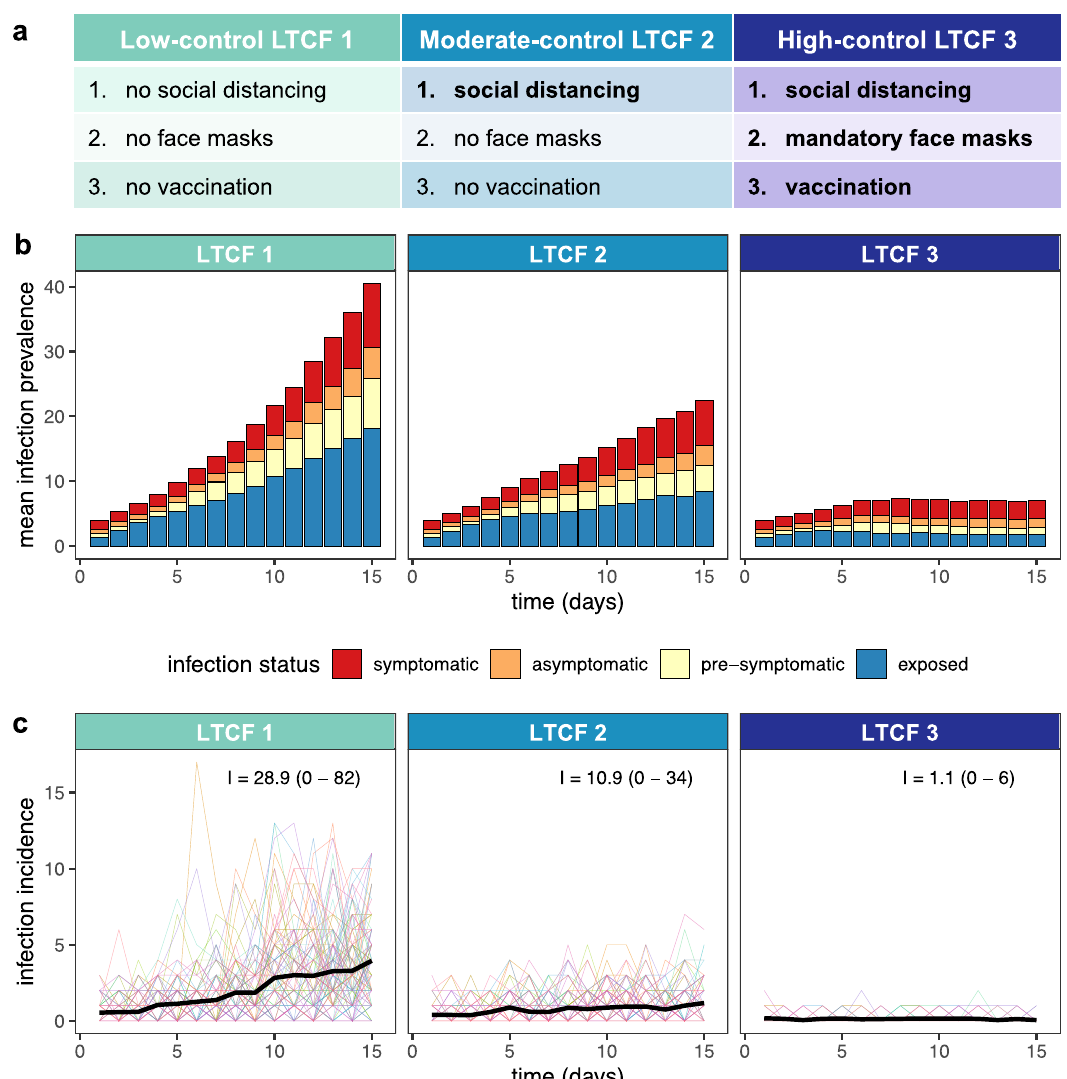
Fig. 1 Modelling context: simulating SARS-CoV-2 outbreaks in a long-term care facility (LTCF) with three different levels of COVID-19 control. a A list of the COVID-19 containment measures in place across low-control LTCF 1, moderate-control LTCF 2, and high-control LTCF 3 (see Supplementary information section I for details). b Daily infection prevalence, the mean number of individuals in each infection stage (colours) over time. Pre-symptomatic infection combines pre-symptomatic and pre-asymptomatic infection, and symptomatic infection combines mild symptomatic and severe symptomatic infection. c Daily nosocomial infection incidence, the number of new SARS-CoV-2 infections acquired within the LTCF each day. Thin coloured lines are individual simulations; the thick black line is the mean across 100 simulations. In text, the mean (range) cumulative nosocomial incidence, I, over two weeks. The proportions of simulations with ≥ 1 cumulative nosocomial cases were 98%, 98% and 59% in LTCFs 1, 2 and 3, respectively; the proportions with ≥ 5 cumulative nosocomial cases were 91%, 73% and 2%; the proportions with ≥ 10 cumulative nosocomial cases were 82%, 55% and 0%; and the proportions with ≥ 25 cumulative nosocomial cases were 51%, 6% and patients or staff. We also evaluated the use of RT-PCR instead of Ag-RDT for screening, maintaining its higher diagnostic sensi- tivity and longer turnaround time (24 h). For all types of screening considered (1-round, 1-round with routine testing, 2-round with routine testing), Ag-RDT screening was more effective for transmission prevention than RT-PCR screening, suggesting that faster turnaround time for Ag-RDT outweighs its reduced sensitivity. This fi nding was robust to a sensitivity ana- lysis considering an alternative curve for diagnostic sensitivity of Ag-RDT relative to RT-PCR (Supplementary Fig. S9b).